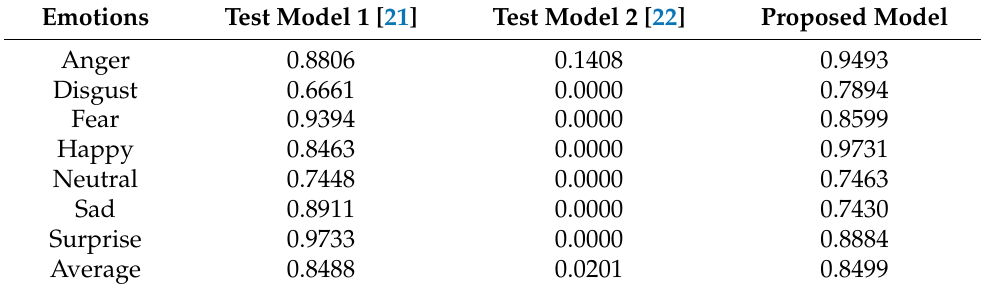
Table 28. Precision comparison between all three models with respect to observation 1 of Experiment 2 with 10 epochs.